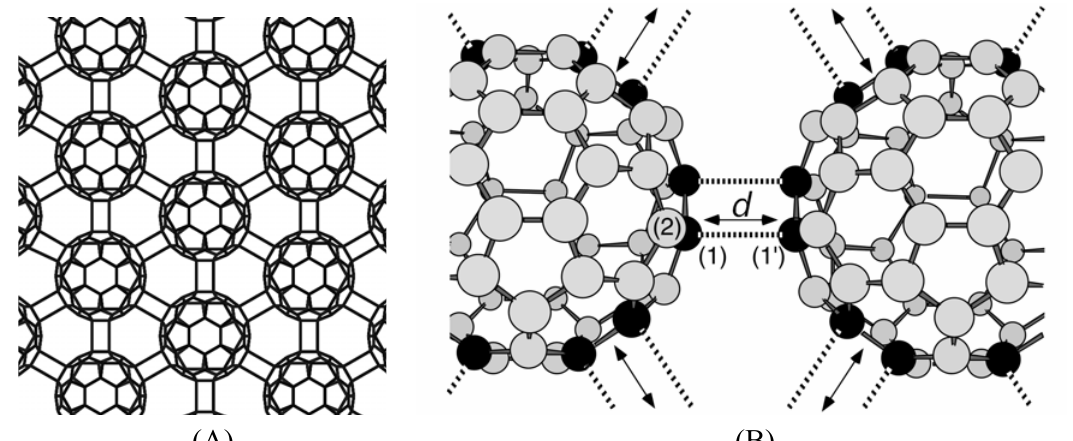
Figure1. The crystal structure of Rh-C . The cell parameters were obtained by Ref. 8. 60 on x-y plane; (B) Covalently bonding carbon (black (A) 2D slab of Rh-C 60 circles) and the other carbons (gray circles); d is the distortion parameter. Only C* (black circles) were